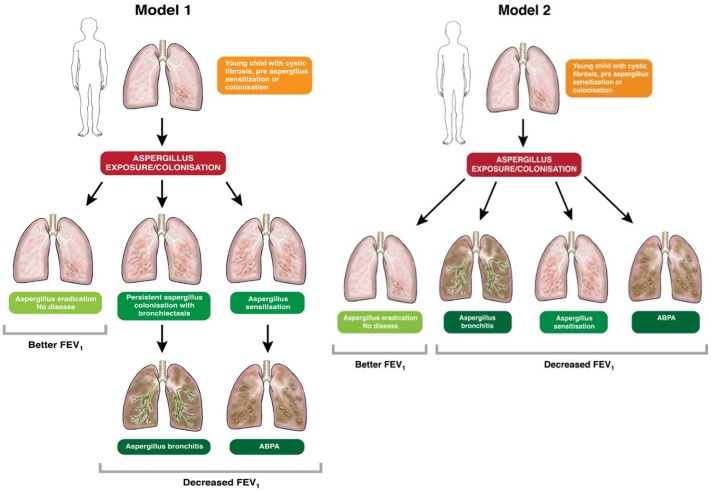
Alternative models of the development of ABPA, Aspergillus sensitisation or Aspergillus bronchitis.